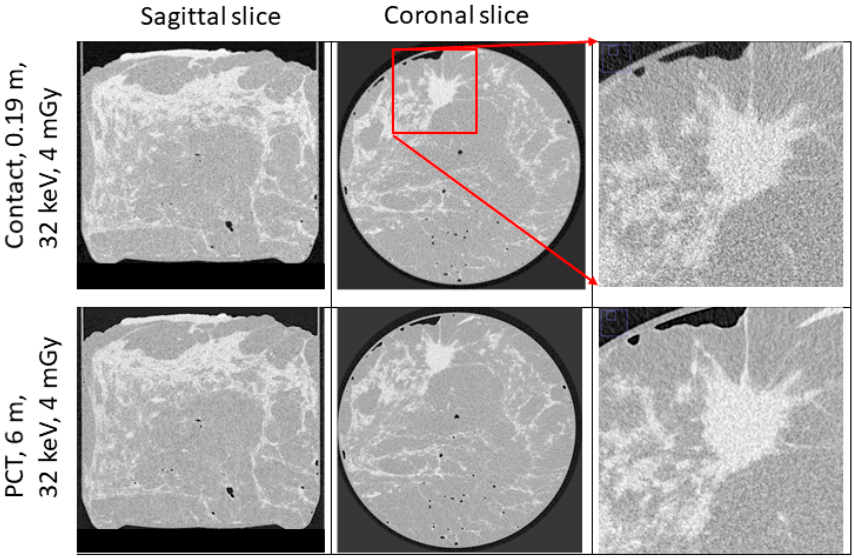
Figure 2. Comparison of absorption-contrast CT at 0.19 m sample-detector distance (top row) with PCT using TIE-Hom phase-retrieval images at a 6 m sample-detector distance (bottom row) of a breast tissue sample. The PCT images exhibit a better signal-to-noise ratio compared to the contact